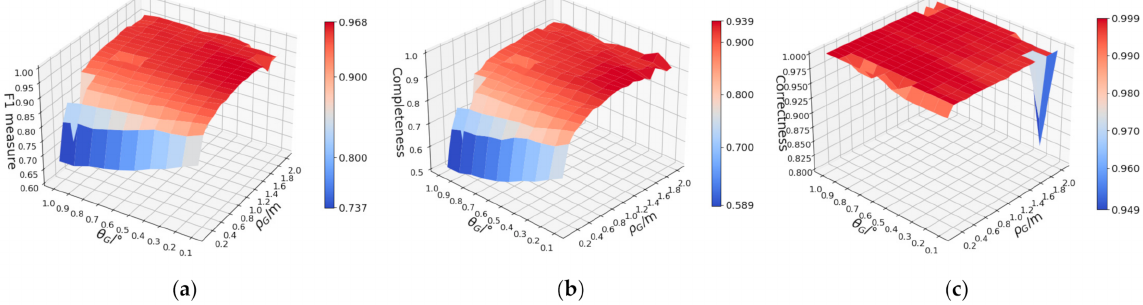
Figure 15. F1 measure ( a ), completeness ( b ) and correctness ( c ) of the proposed method under different parameter